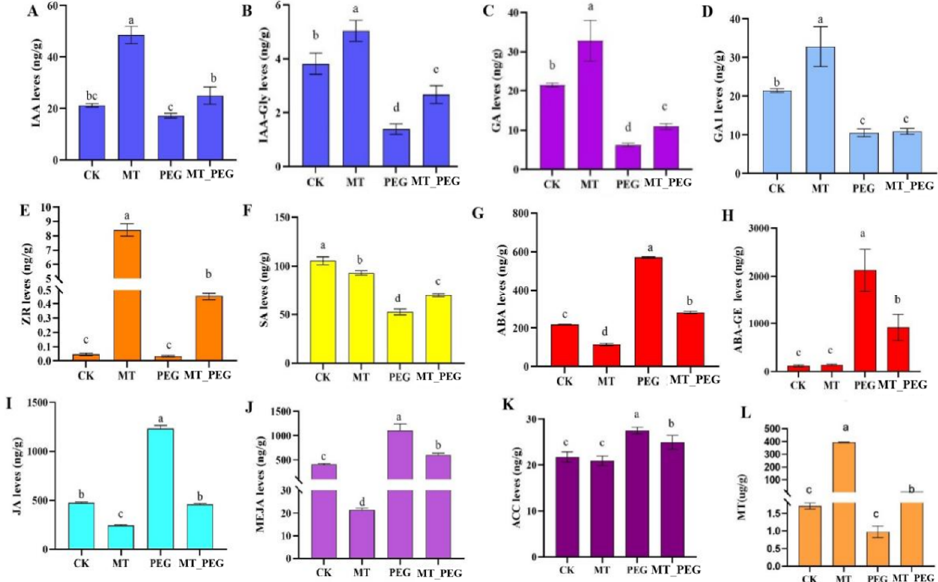
Figure 3. Effect of exogenous melatonin on the endogenous hormone levels of chrysanthemum seedlings under drought stress. Contents of ( A ) IAA (auxin), ( B ) IAA-Gly (Indole-3-acetyl glycine), ( C ) GA (Gibberellin), ( D ) GA1 (Gibberellin A1), ( E ) ZR (zeatin riboside), ( F ) SA (salicylic acid), ( G ) ABA (abscisic acid), ( H ) ABA-GE (abscisic acid-glucosyl ester), ( I ) JA (Jasmonic acid), and ( J ) MEJA (methyl jasmonate). Contents of ( K ) ACC (ethylene) and ( L ) MT (melatonin). CK, control; MT, exogenous melatonin treatment; PEG, drought stress; MT_PEG, drought stress with exogenous melatonin treatment. The data are presented as the means ± SEs (n = 3). Different letters indicate significant differences at p < 0.05.